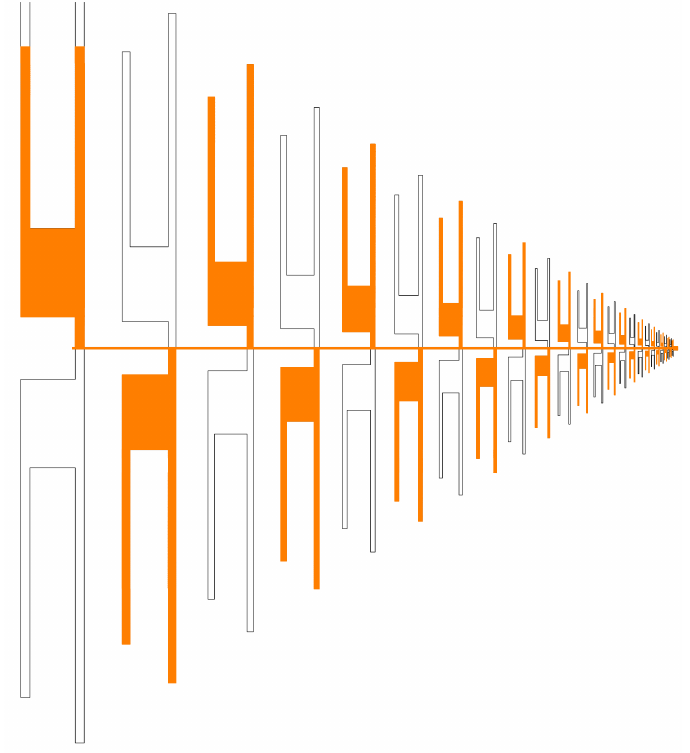
Figure 7. PLPDA design with dual-band dipoles